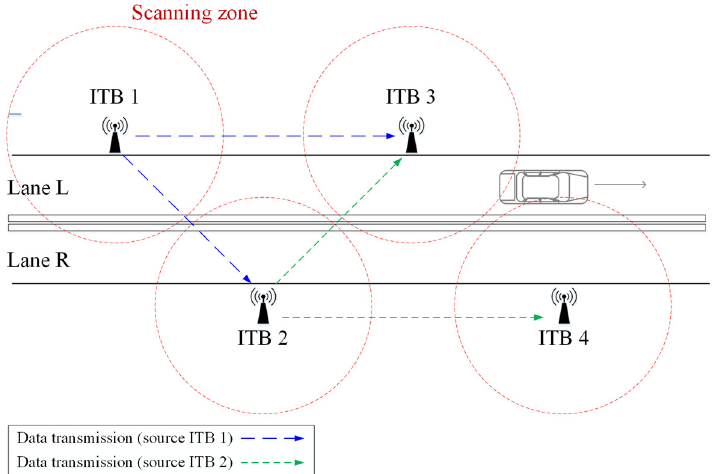
Figure 1. The Z-type topology (Fan